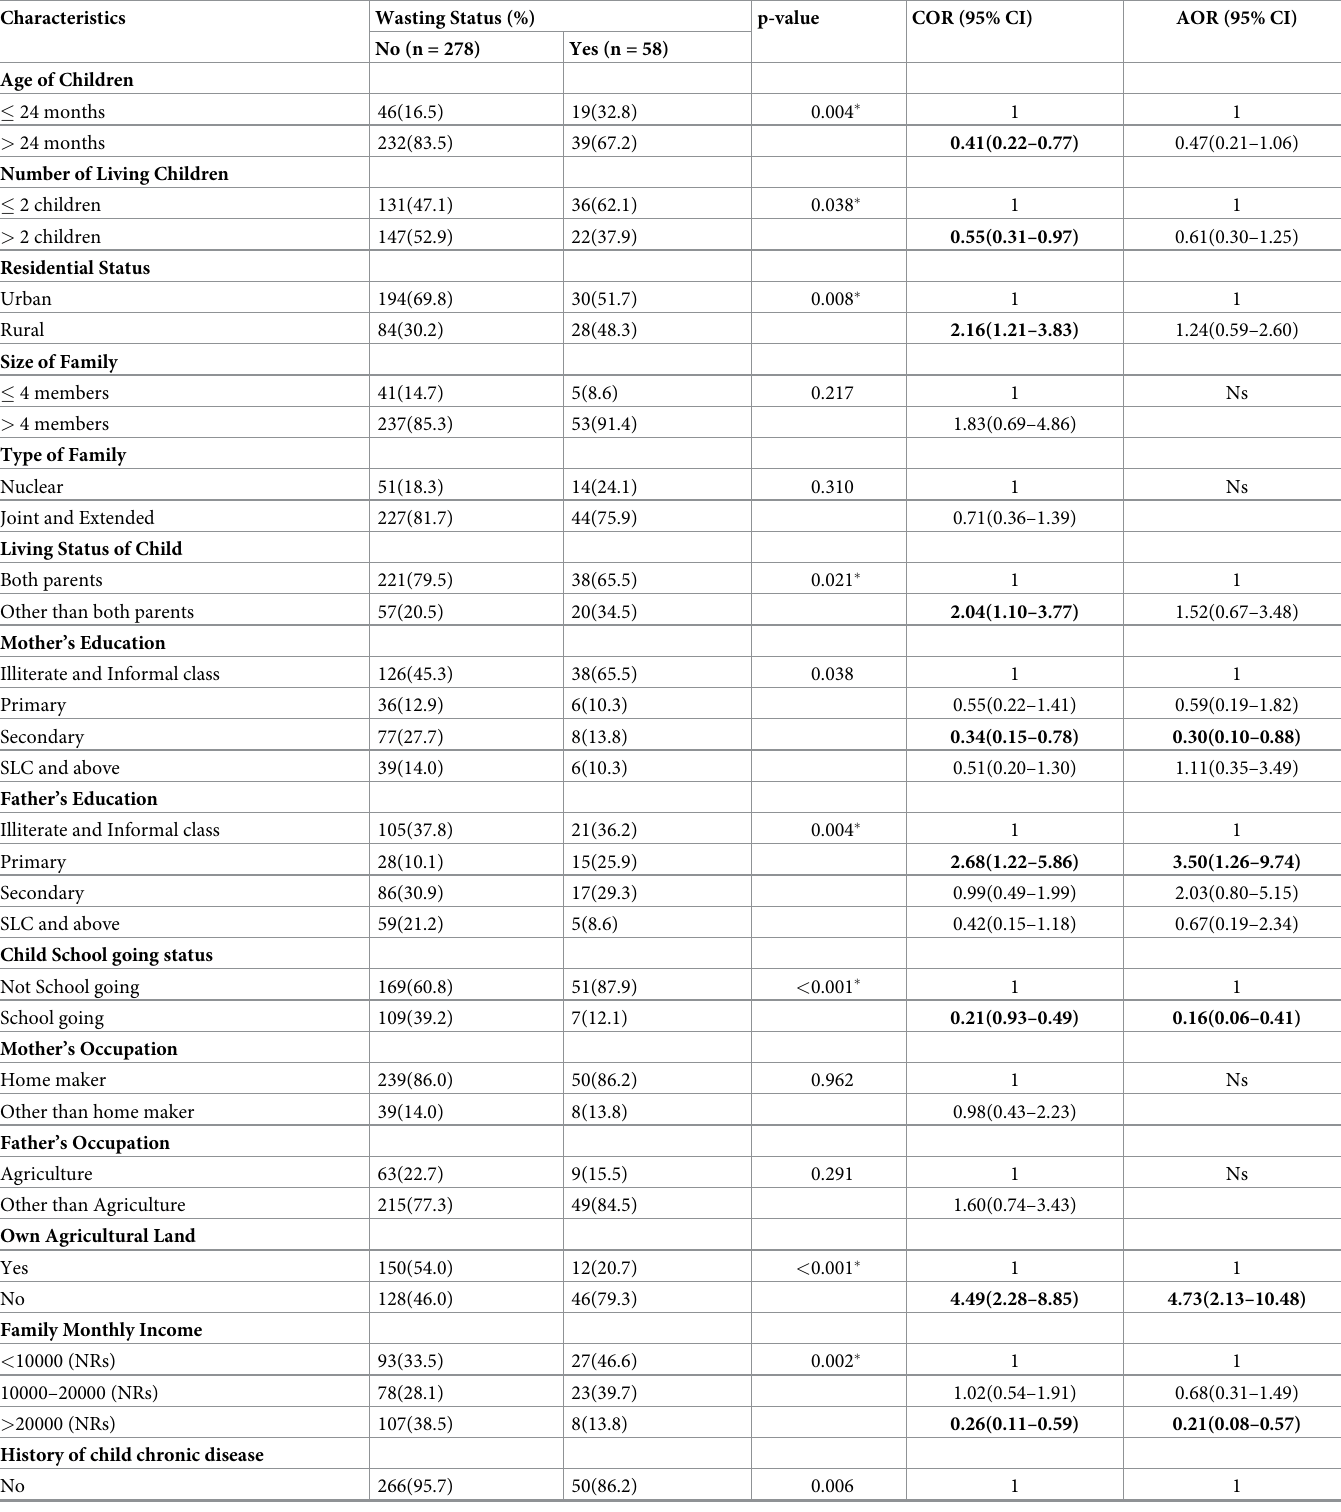
Table 5. Factors associated with wasting in using bivariate and multivariate regression model.